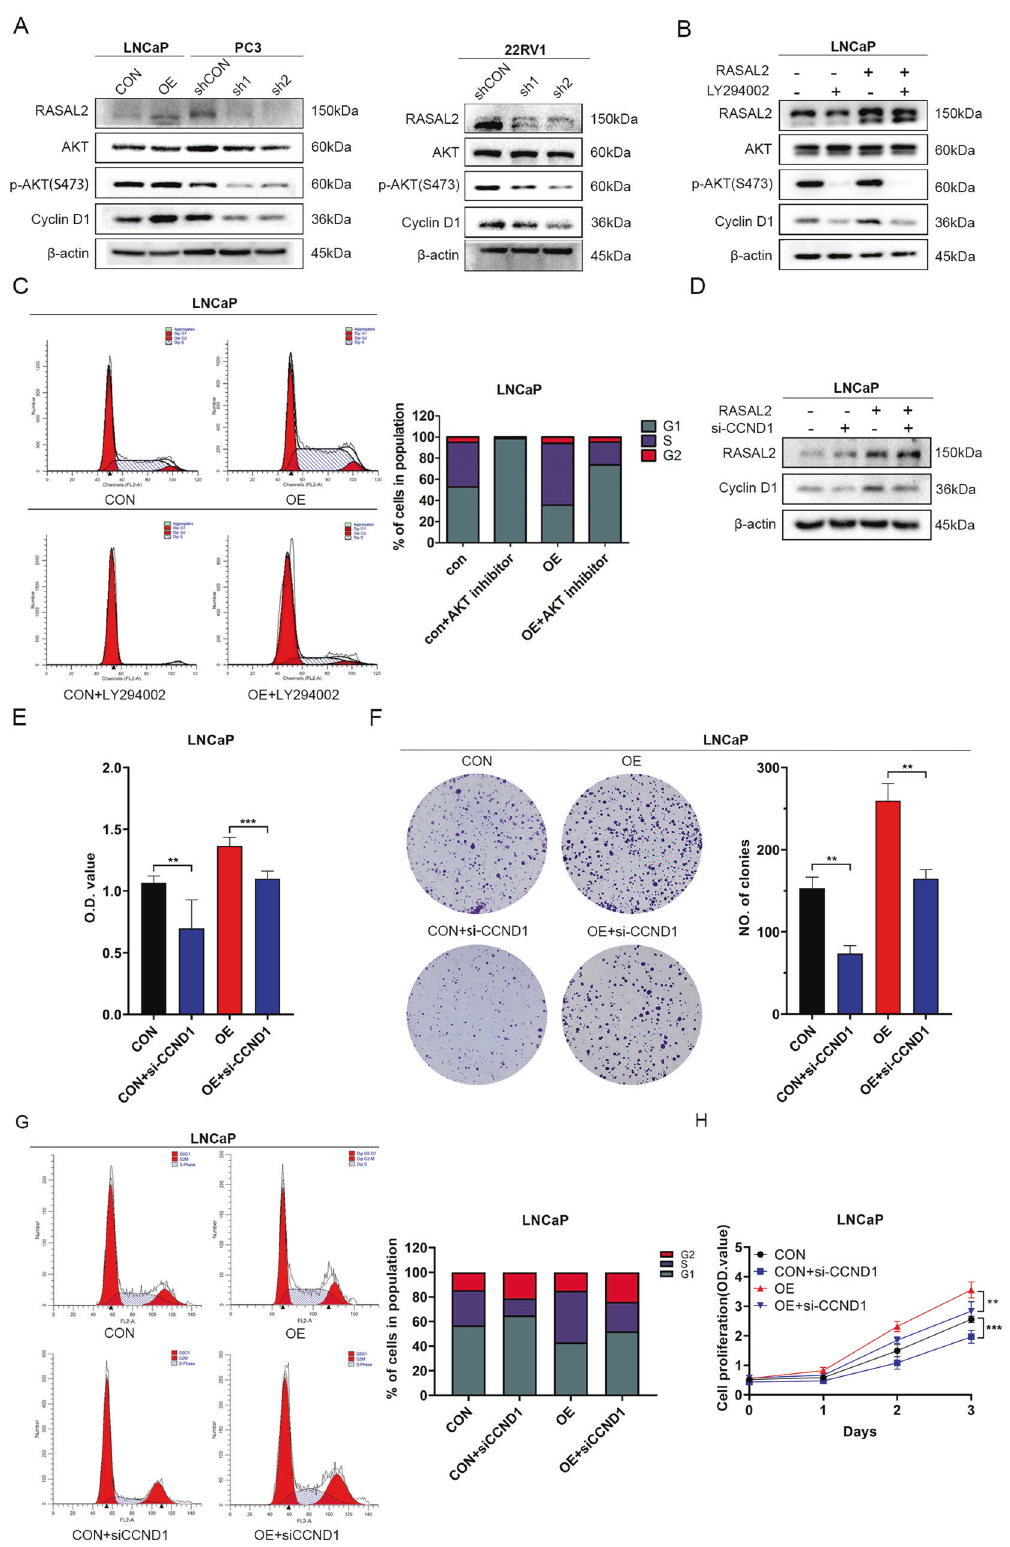
Fig. 4 RASAL2 regulates PCa cell proliferation via PI3K/AKT/cyclin D1 signalling. A Western blotting analysis of AKT, p-AKT and cyclin D1 expression levels in established cell lines. B Western blotting analysis of AKT, p-AKT and cyclin D1 expression in the LNCaP cell line treated with an AKT inhibitor. C Flow cytometry analysis of AKT inhibitor-treated LNCaP cell lines. D Western blotting analysis of cyclin D1 expression levels in the siCCND1-treated LNCaP cell line. Cell viability ( E ), colony formation ( F ), cell cycle ( G ) and cell proliferation ( H ) assays in siCCND1- treated LNCaP cell